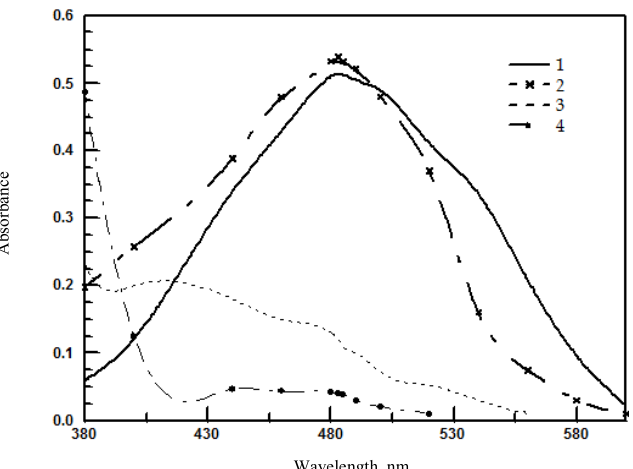
Figure 1. Absorption spectra of the reaction product resulting from reaction of (1) 50 µg/mL cefepime HCl measured against reagent blank (3) and (2) 20 µg/mL cefuroxime Na measured against reagent blank (4) with